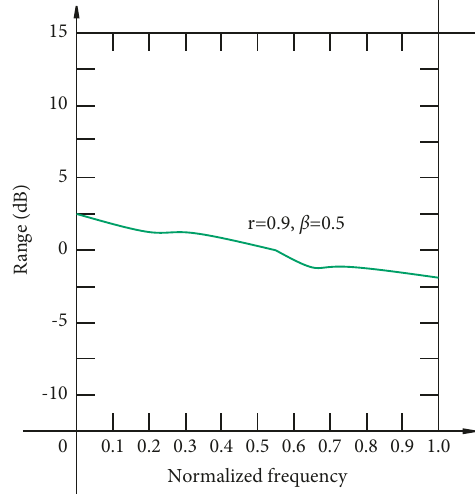
Figure 3: Frequency response of the short-time